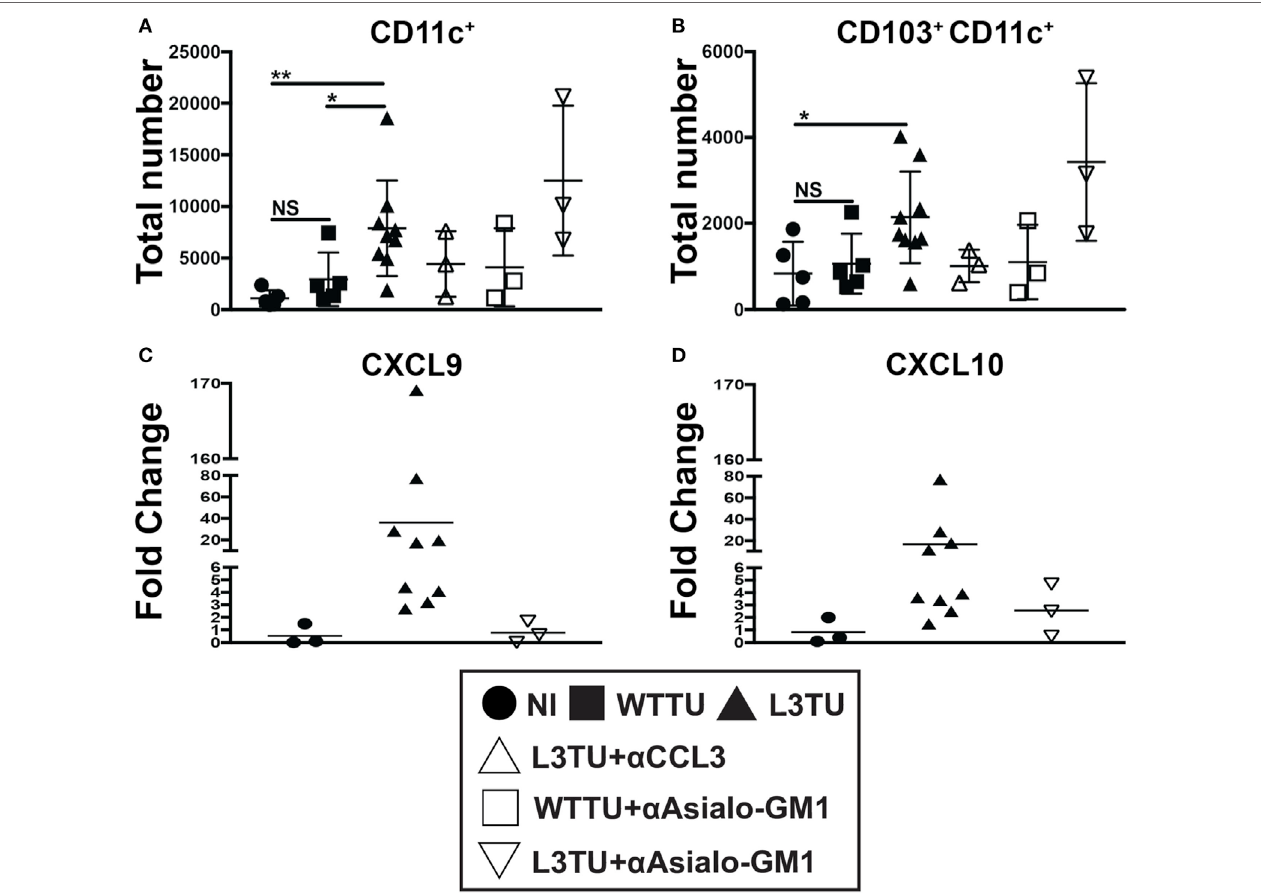
FigUre 5 | Natural killer (NK) cells, not CD103 + CD11c + dendritic cells (DCs), drive IFN γ -induced CXCL9 and CXCL10 production in the L3TU tumor-draining lymph node (TDLN). (a,B) Absolute total and CD103 + subset of CD11c + cell numbers in the TDLN 5-days post-tumor injections were numerated by FACS. N = 3 mice per cohort. non-injected (NI), WTTU, and L3TU injection groups were conducted simultaneously with each depletion experiment and combined into the present graphs. IgG1a antibody was administered to NI, WTTU, and L3TU cohorts as for CCL3 blockade or NK depletion. (c,D) Fold change of CXCL9 and CXCL10 mRNA expression in the L3TU TDLN compared to that of WTTU group. Lymph nodes (LNs) from two to three mice in the NI group were pooled for analysis due to low mRNA content. Not significant (ns), p > 0.05; * p = 0.01–0.05; ** p = 0.001–0.01; *** p = 0.0001–0.001; **** p <